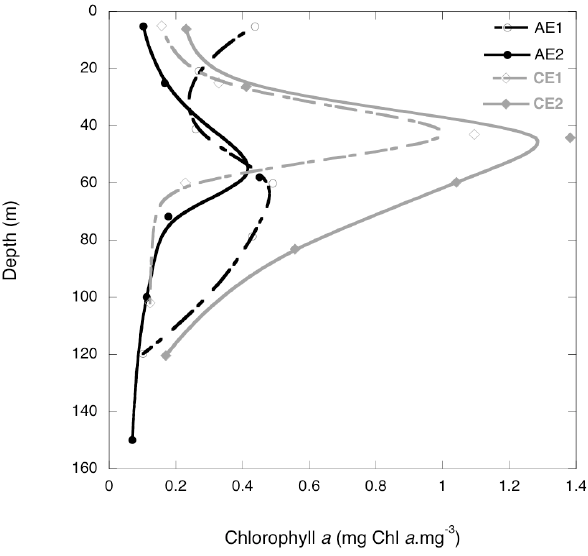
Fig. 5. Chlorophyll a depth profiles at the two anticyclonic eddies (AE1 and AE2) and at the two cyclonic eddies (CE1 and CE2).